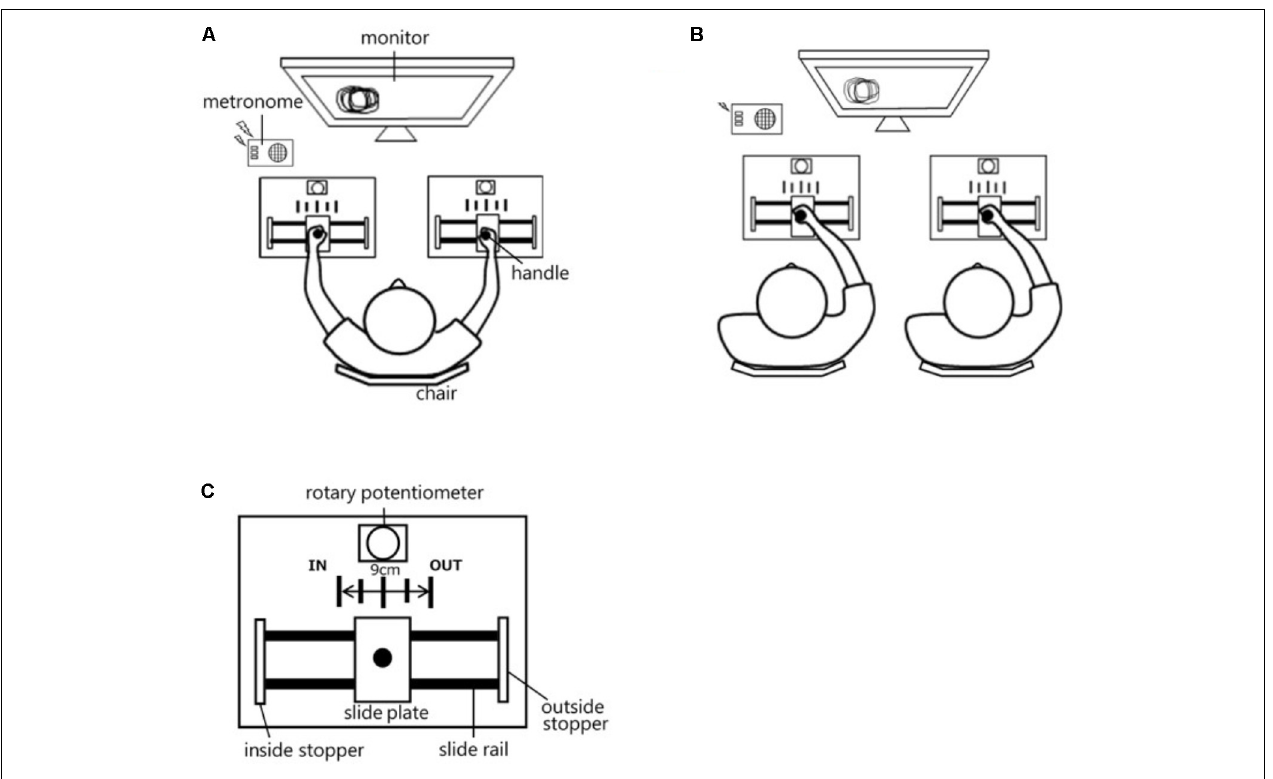
FIGURE 1 | Schematic diagrams of Experiment 1 (A) , and Experiment 2 (B) . Detail drawing of the experimental equipment (C) .